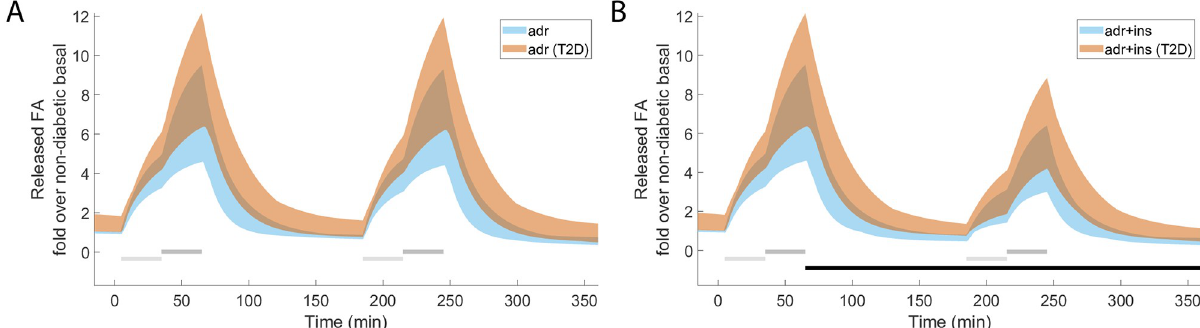
Fig 7. Simulations of fatty acid release in vivo , under both non-diabetic (blue) and type 2 diabetic conditions (orange). In both panels, the shaded areas represent the model simulation uncertainty. In both panels (A-B) horizontal light grey bars indicate where stimulation with 1 μ M adrenaline was given, dark grey bars indicate where stimulation with 10 μ M adrenaline was given, and horizontal black bars indicate where stimulation with 0.6 nM insulin was given. (A), model prediction without insulin, and (B), with insulin.